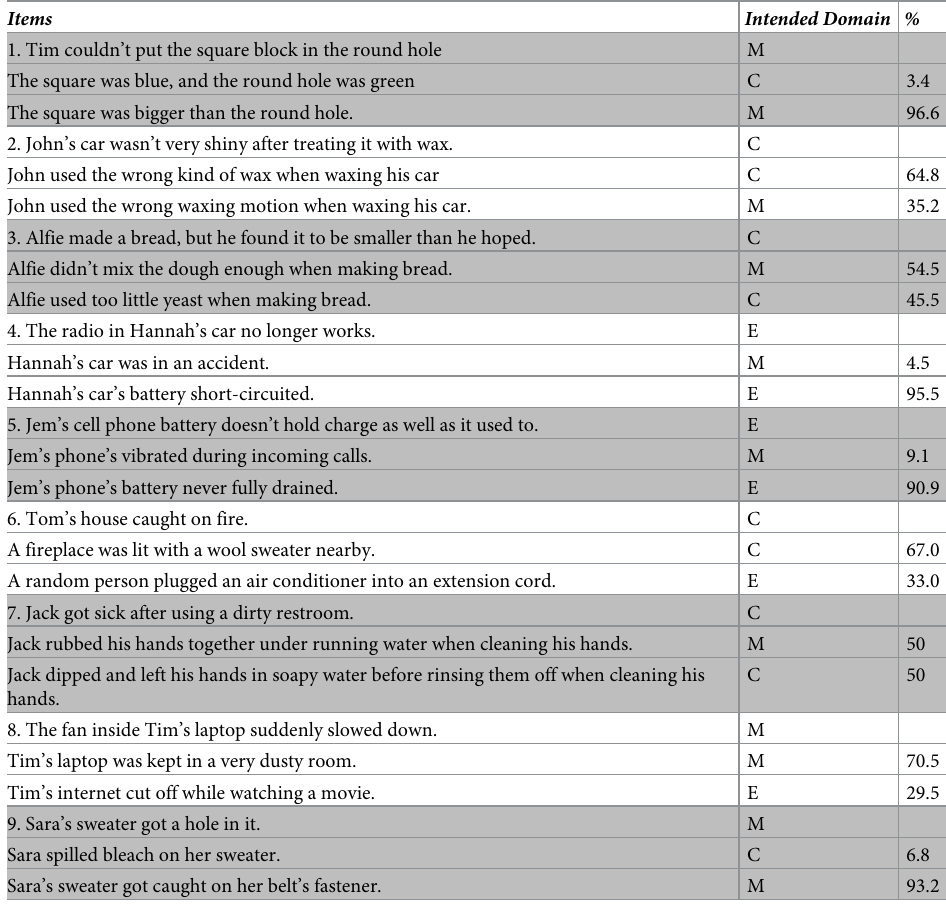
Table 4. Triplets. Items Intended Domain